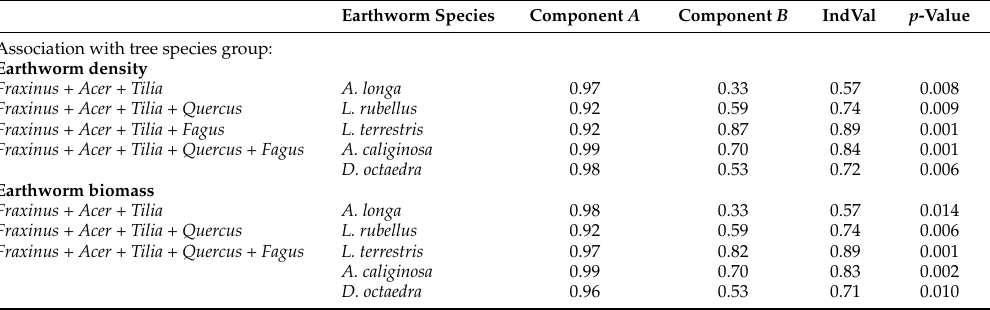
Table A5. Indicator species analysis of earthworm density and biomass. The indicator component A (specificity) relates to the probability that the earthworm species only occurs in this group of tree species. The indicator component B (sensitivity) relates to the probability of finding the earthworm species in this group of tree